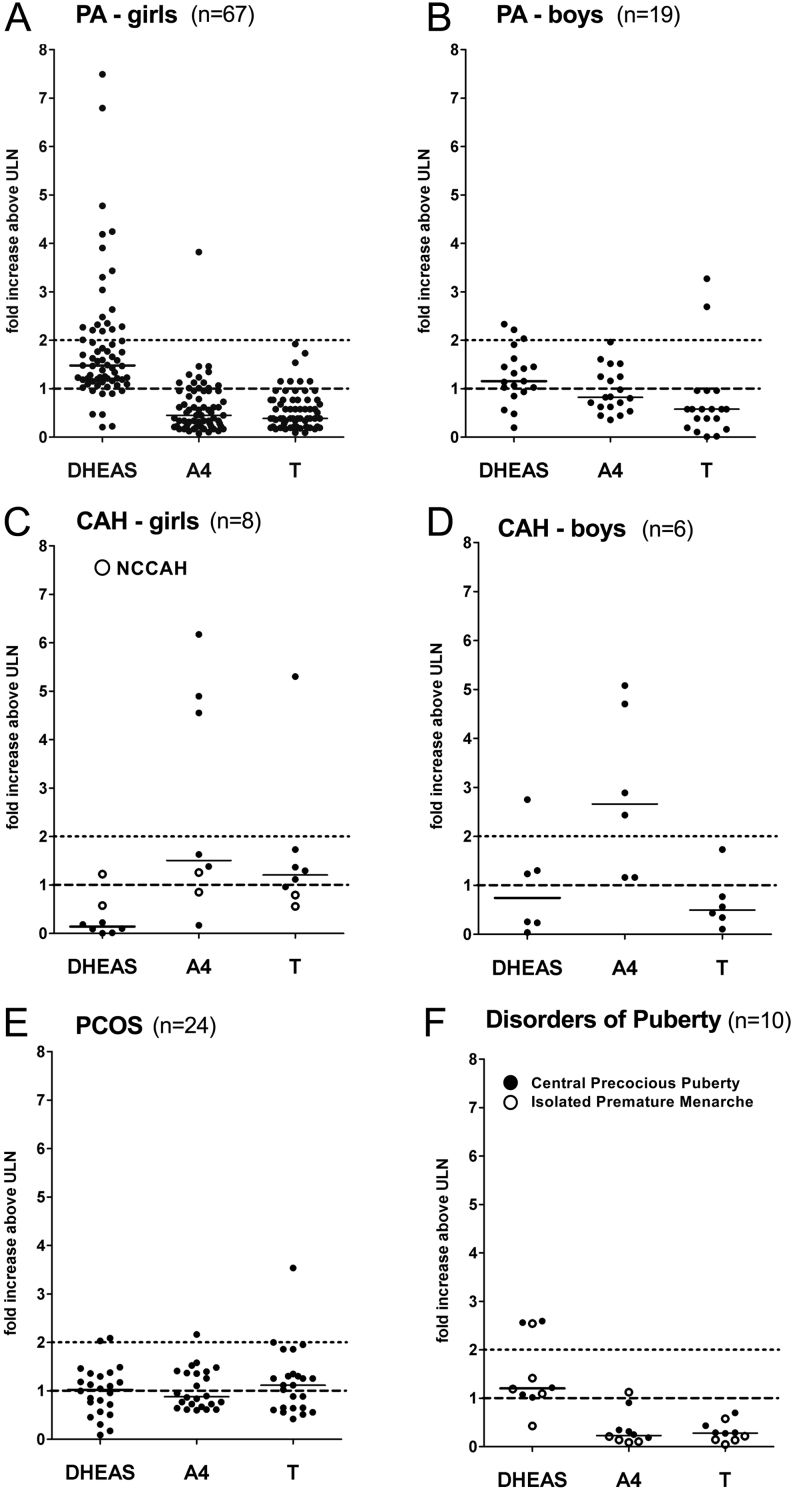
Severity of androgen excess according to diagnosis (A–F) and serum androgen measured. (A) premature adrenarche (PA) in girls; (B) PA in boys; (C) congenital adrenal hyperplasia (CAH) in girls (closed circles: classic CAH; open circles: non-classic CAH); (D) CAH in boys; (E) polycystic ovary syndrome (PCOS); (F) disorders of puberty (closed circles: central precocious puberty; open circles: isolated premature menarche). Androgen excess levels are represented as ‘fold increase above upper limit of normal, ULN’; levels above ‘1’ therefore indicate androgen excess, indicated by the black interrupted line. An arbitrary defined cut-off for severe androgen excess from 2-fold ULN is indicated by a black dotted line.